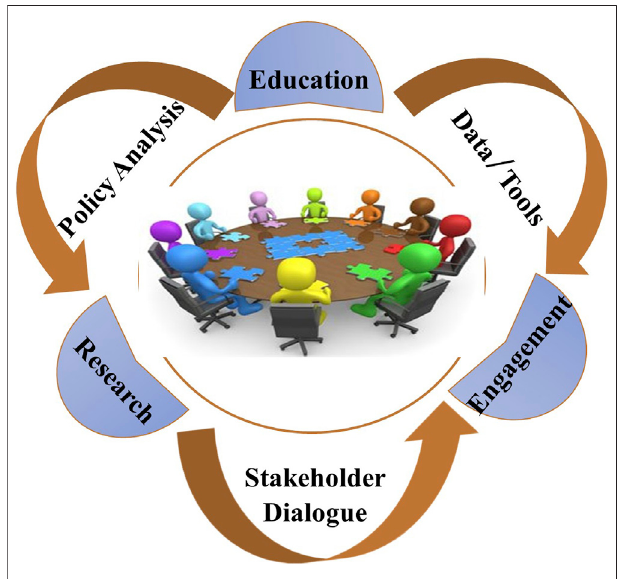
FIGURE 1 | The nexus community of science and